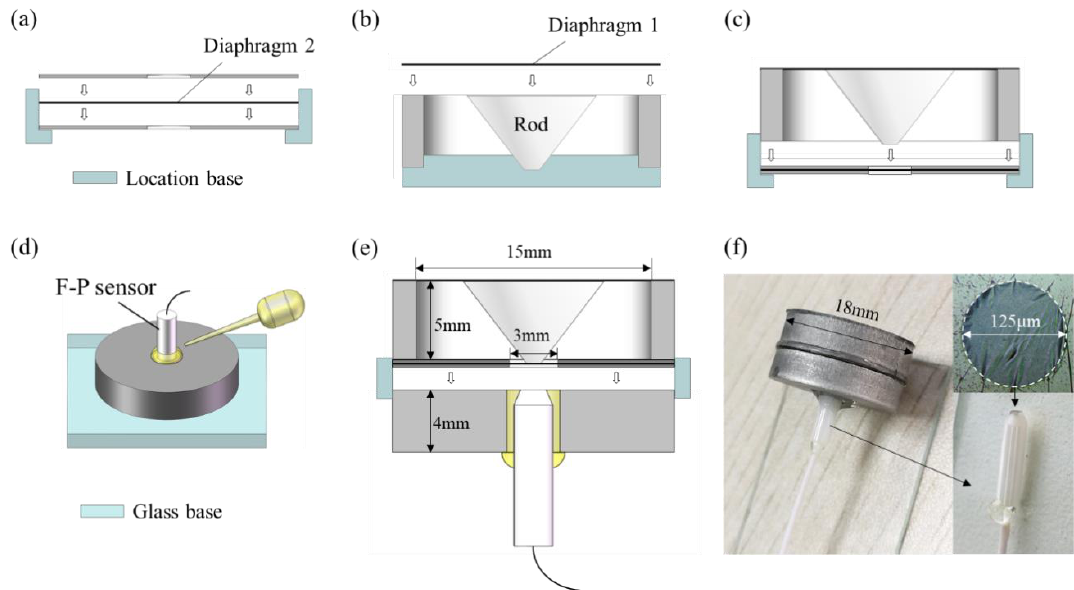
Figure 5. Fabrication process of the SPAS. ( a ) Clamping diaphragm 2 between two steel gaskets. ( b ) Bonding diaphragm 1 onto the endface of a steel casing. ( c ) Fixing the parts that make up the SPAS. ( d ) Inserting an F-P probe into a location base. ( e ) Assembling the casing with the locating base installed with an F-P probe by epoxy glue. ( f ) Picture of the assembled SPAS.